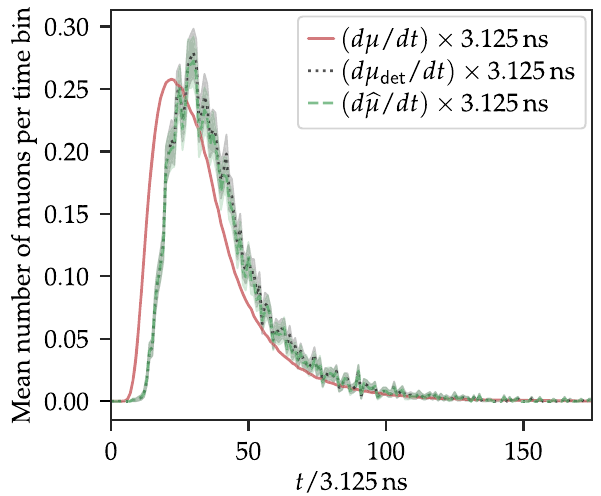
Fig. 15 Input number of muons (solid line), input number of muons as seen by the detector (dotted line), and reconstructed number of muons (dashed line) using the 1-bin strategy, as a function of time. The input number of muons as a function of time are the average muon profile of proton showers with 17 . 8 ≤ log 10 ( E / eV ) ≤ 18 . 0 and θ (cid:2) 18 ◦ (sin 2 θ ≤ 0 . 10) at 450m from the core. The average number of muons as seen by the detector is computed by introducing the time delays from the detector in the input muons. The shaded areas represent 1 σ